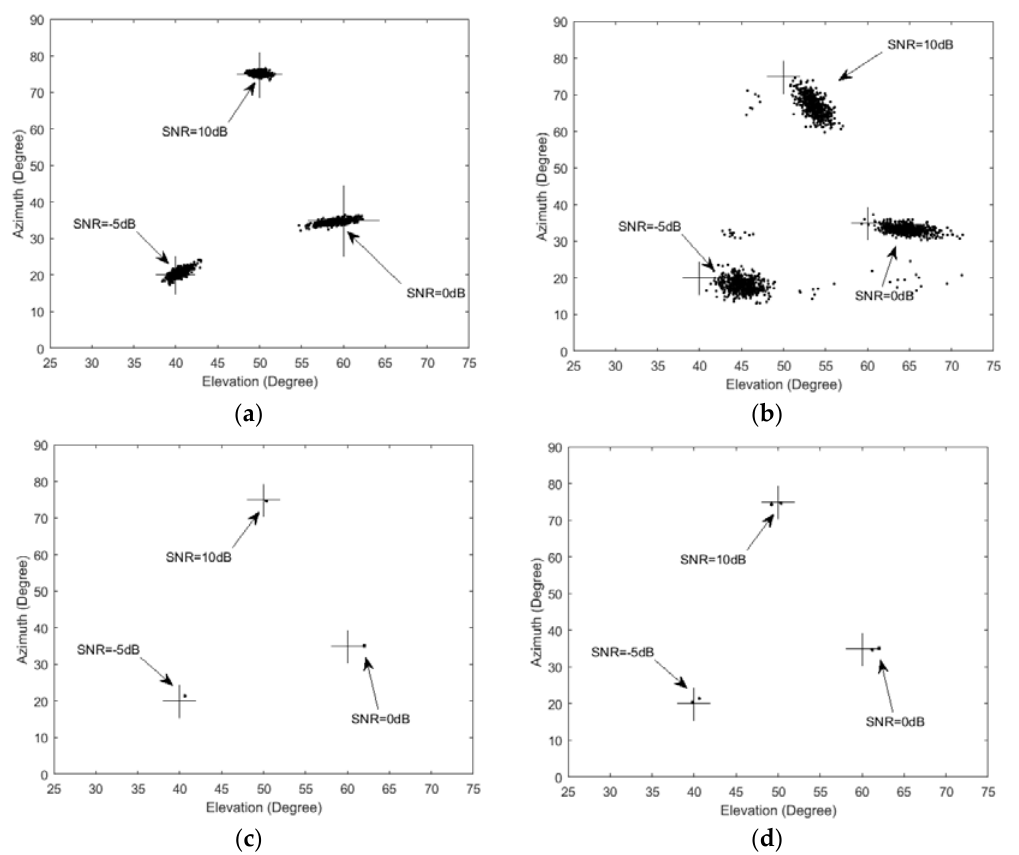
Figure 9. Scatter plots of estimated 2D angles when three sources with different SNR level are impinging on the URA. ( a ) Classic 2D MUSIC algorithm; ( b ) PIE algorithm; ( c ) The proposed AESS algorithm; ( d ) The proposed AESS algorithm with a slightly enlargement of the radius of the third round searching.